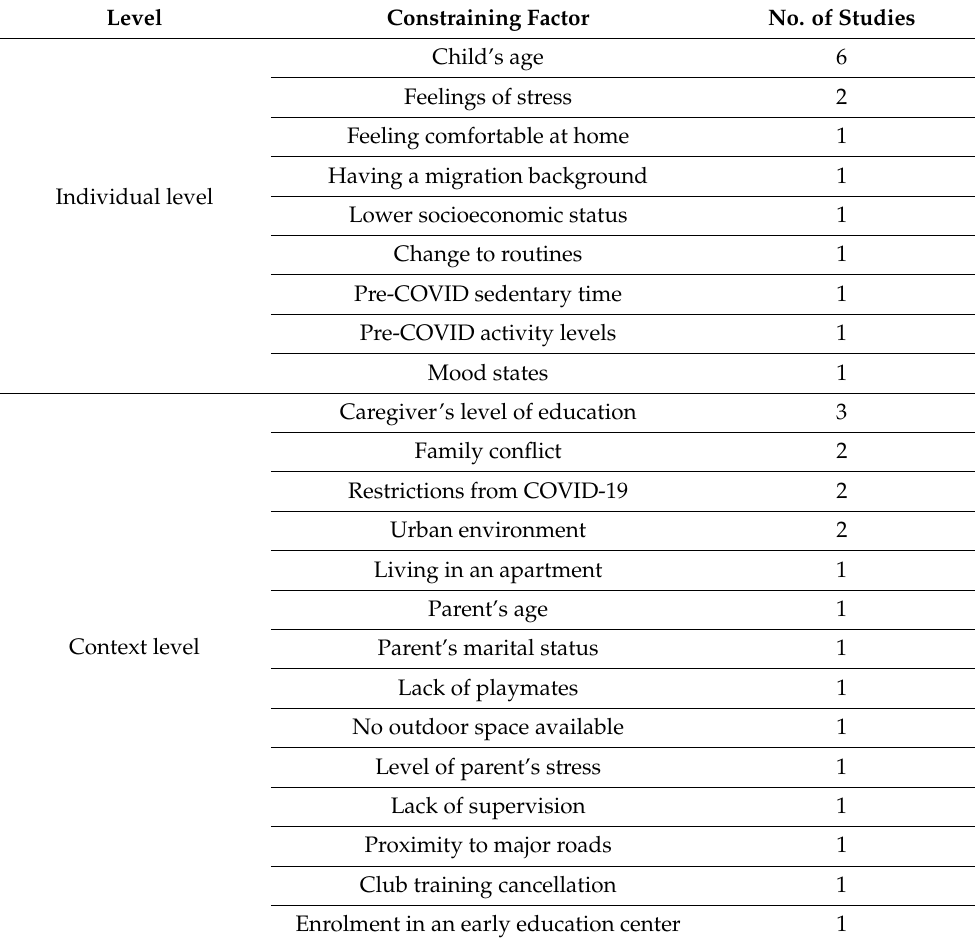
Table 3. Constraining factors in children’s physical activity (PA) during the COVID-19